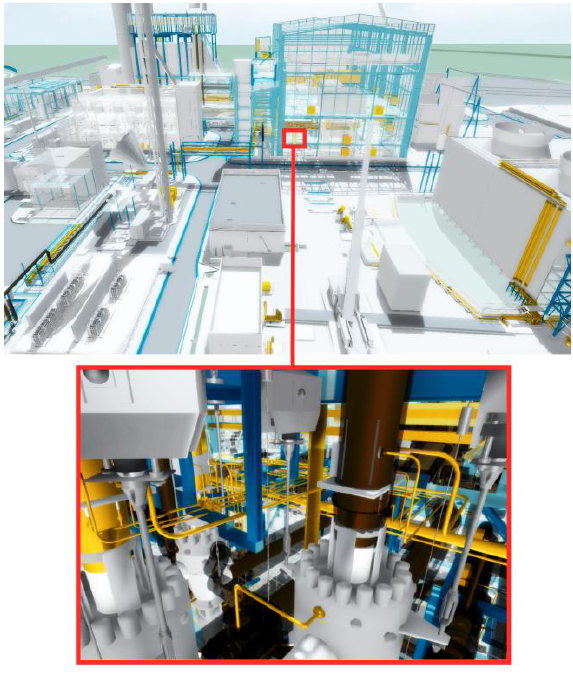
Figure 9: displaying a very large 3D model (a whole EDF power plant with many multi-floor buildings) using streaming processes on a Microsoft Surface 2 Tablet (average of 25 fps). Left: global view of a power plant site with low Level of Detail. Right: detail of the mock-up by zooming on the model; high Level of Detail are load dynamically when zooming on the